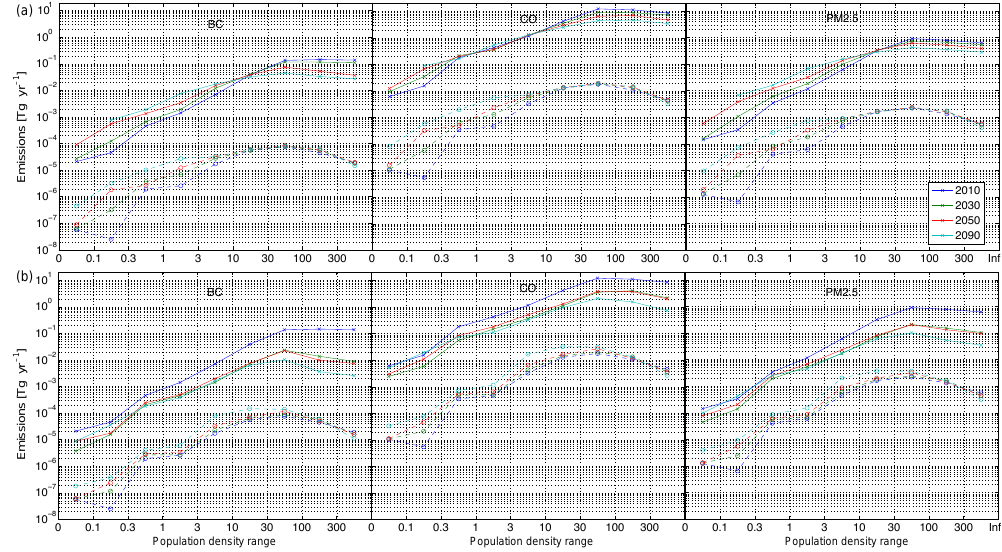
Figure A4. Annual anthropogenic (solid lines, crosses) and wildfire emissions (dashed lines, circles) for Europe by range of population density for selected pollutants and time windows. (a) RCP4.5 climate, SSP5 population and current legislation (CLE) for anthropogenic emissions; (b) RCP8.5 climate, SSP3 population and maximum feasible reduction (MFR) for anthropogenic emissions.